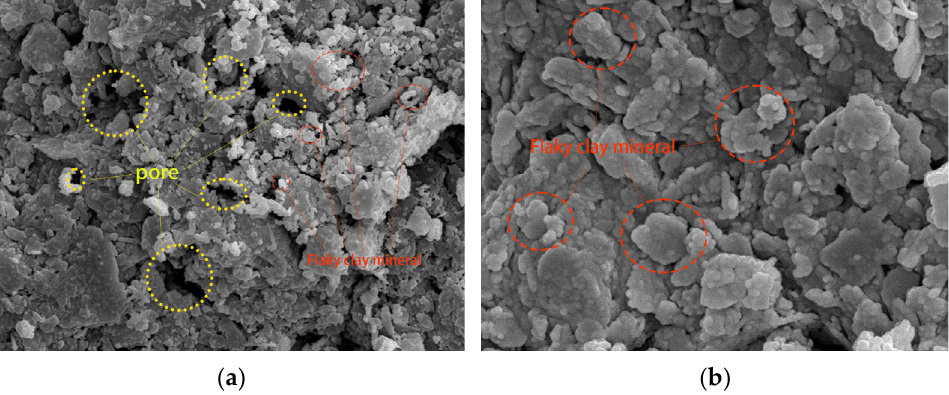
Figure 5. Micromorphology of untreated sand soil: ( a ) pore; ( b ) flaky clay mineral.